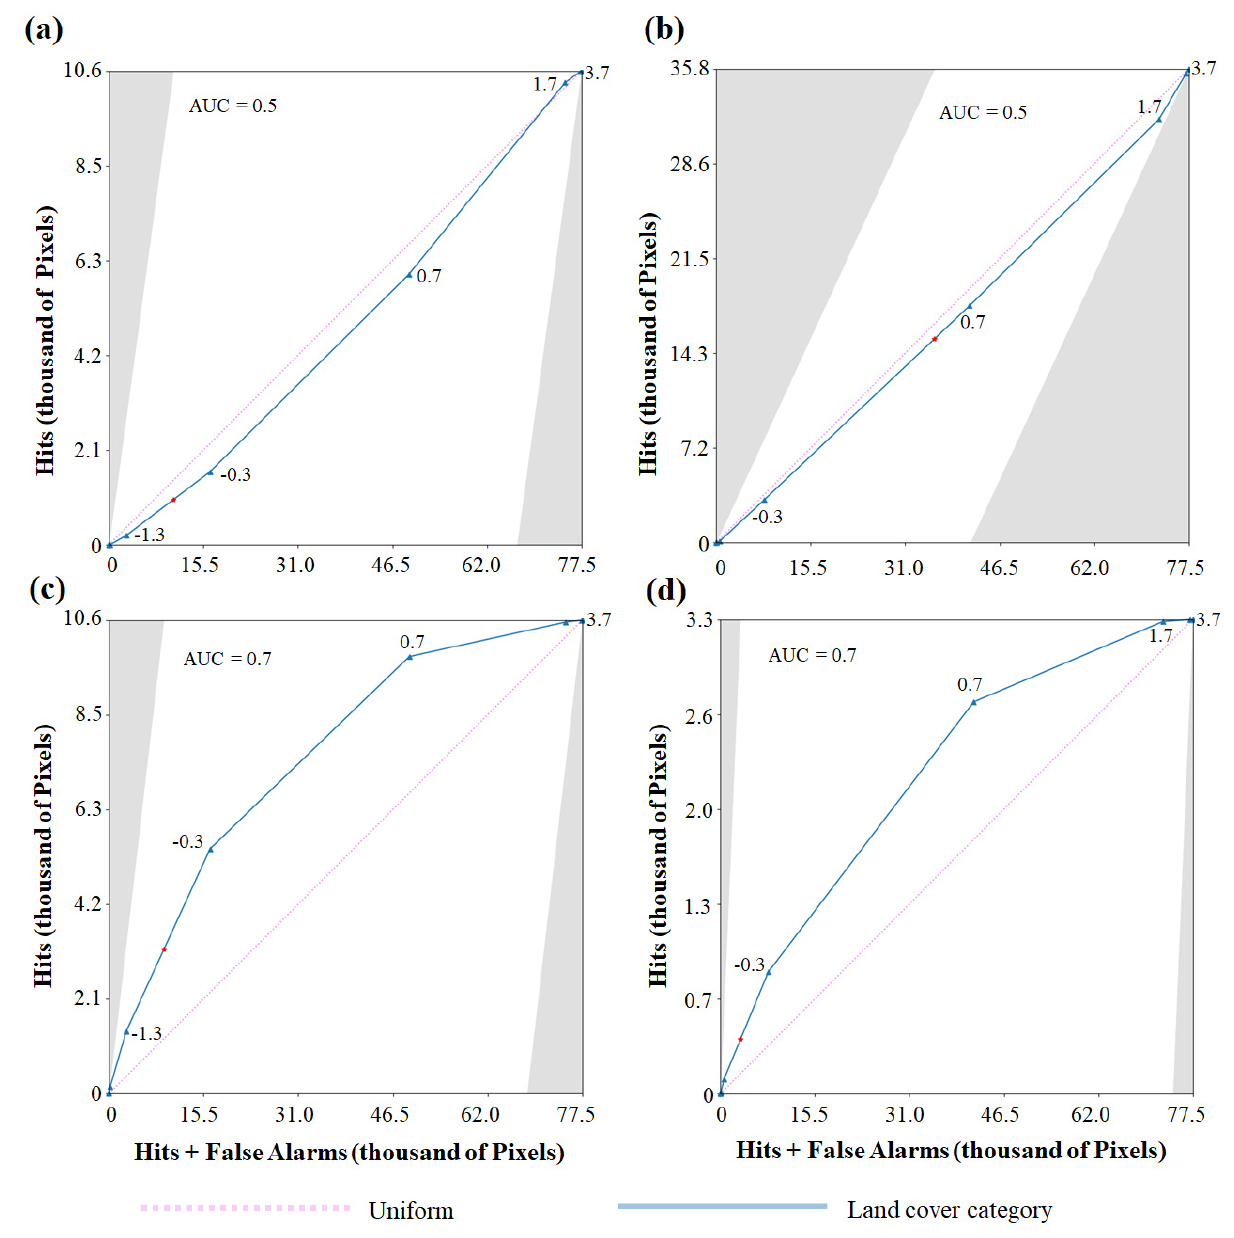
Figure 8. TOC curves for the gains of ( a , b ) infrastructure during the first and second time intervals and ( c , d ) vegetation during the first and second time intervals.